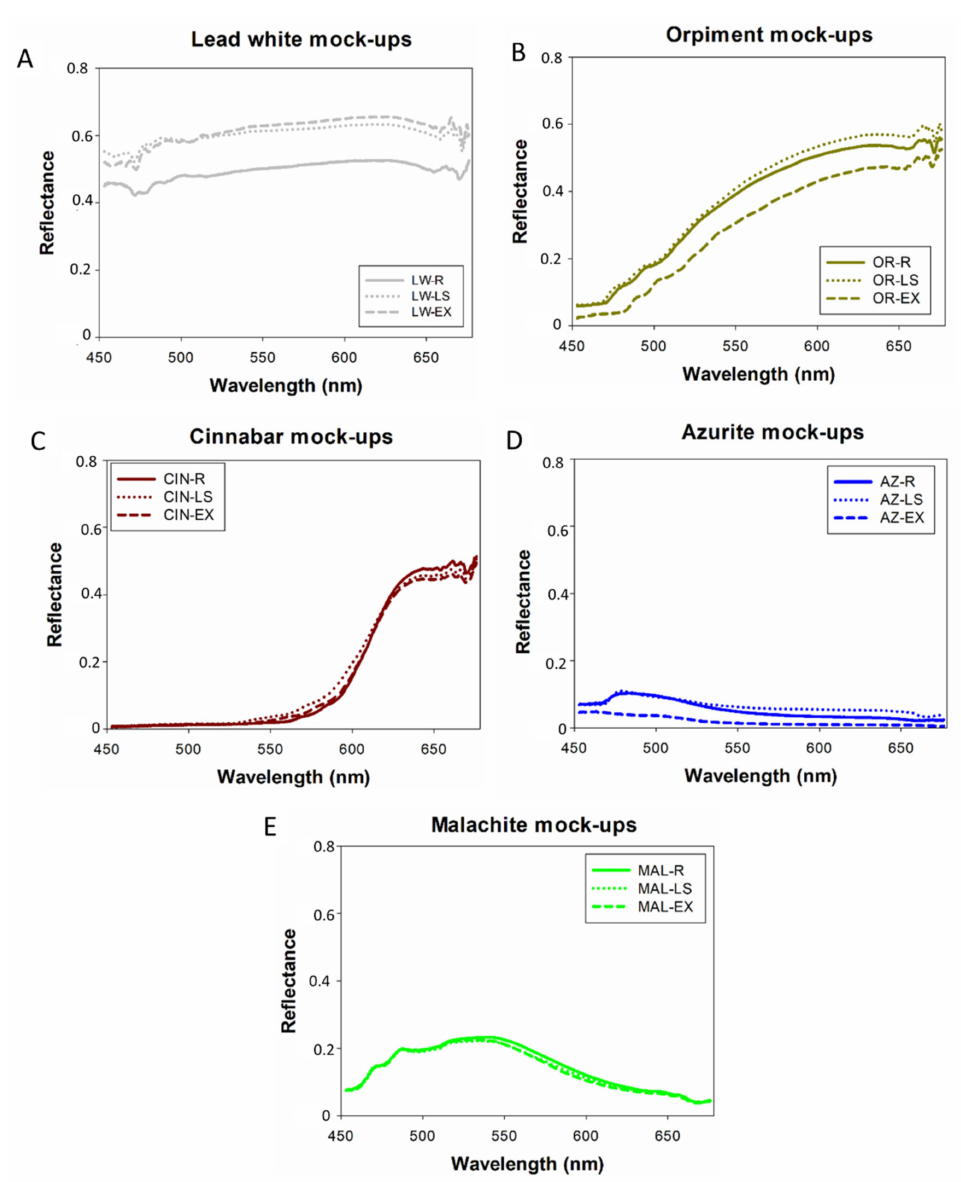
Figure 5. Reflectance spectra of the painting mock-ups used to determine the influence of the binder quantity (O-optimal quantity-, LS-low binder- and EX-excess binder-) on the